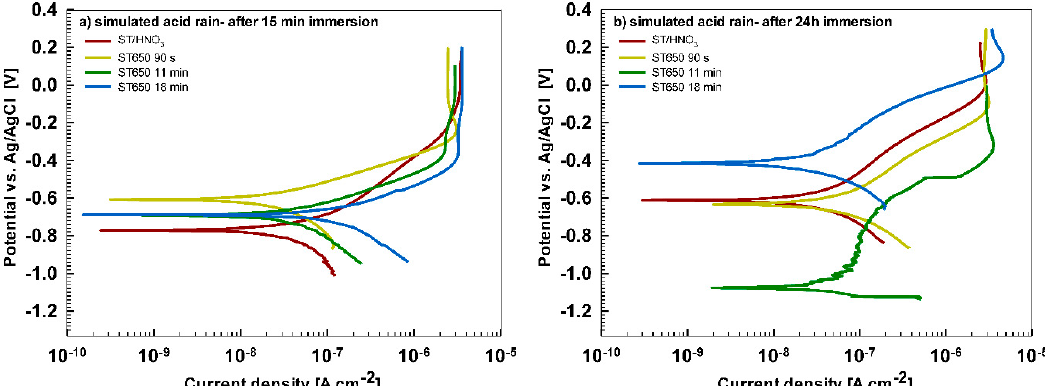
Figure 13. Potentiodynamic polarization curves in simulated acid rain after ( a ) 15 min immersion; ( b ) 24 h immersion for AA3003 samples coated with 10 % ST650 prepared for different conversion times: 90 s, 11 min and 18 min at room temperature. The samples were chemically pre-treated using ST/HNO 3 and the bare sample is given for comparison. The scan rate was 1 mV/s.